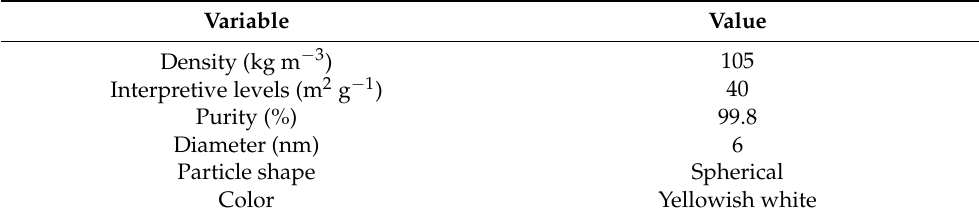
Table 1. Zinc oxide nanoparticle characteristics.